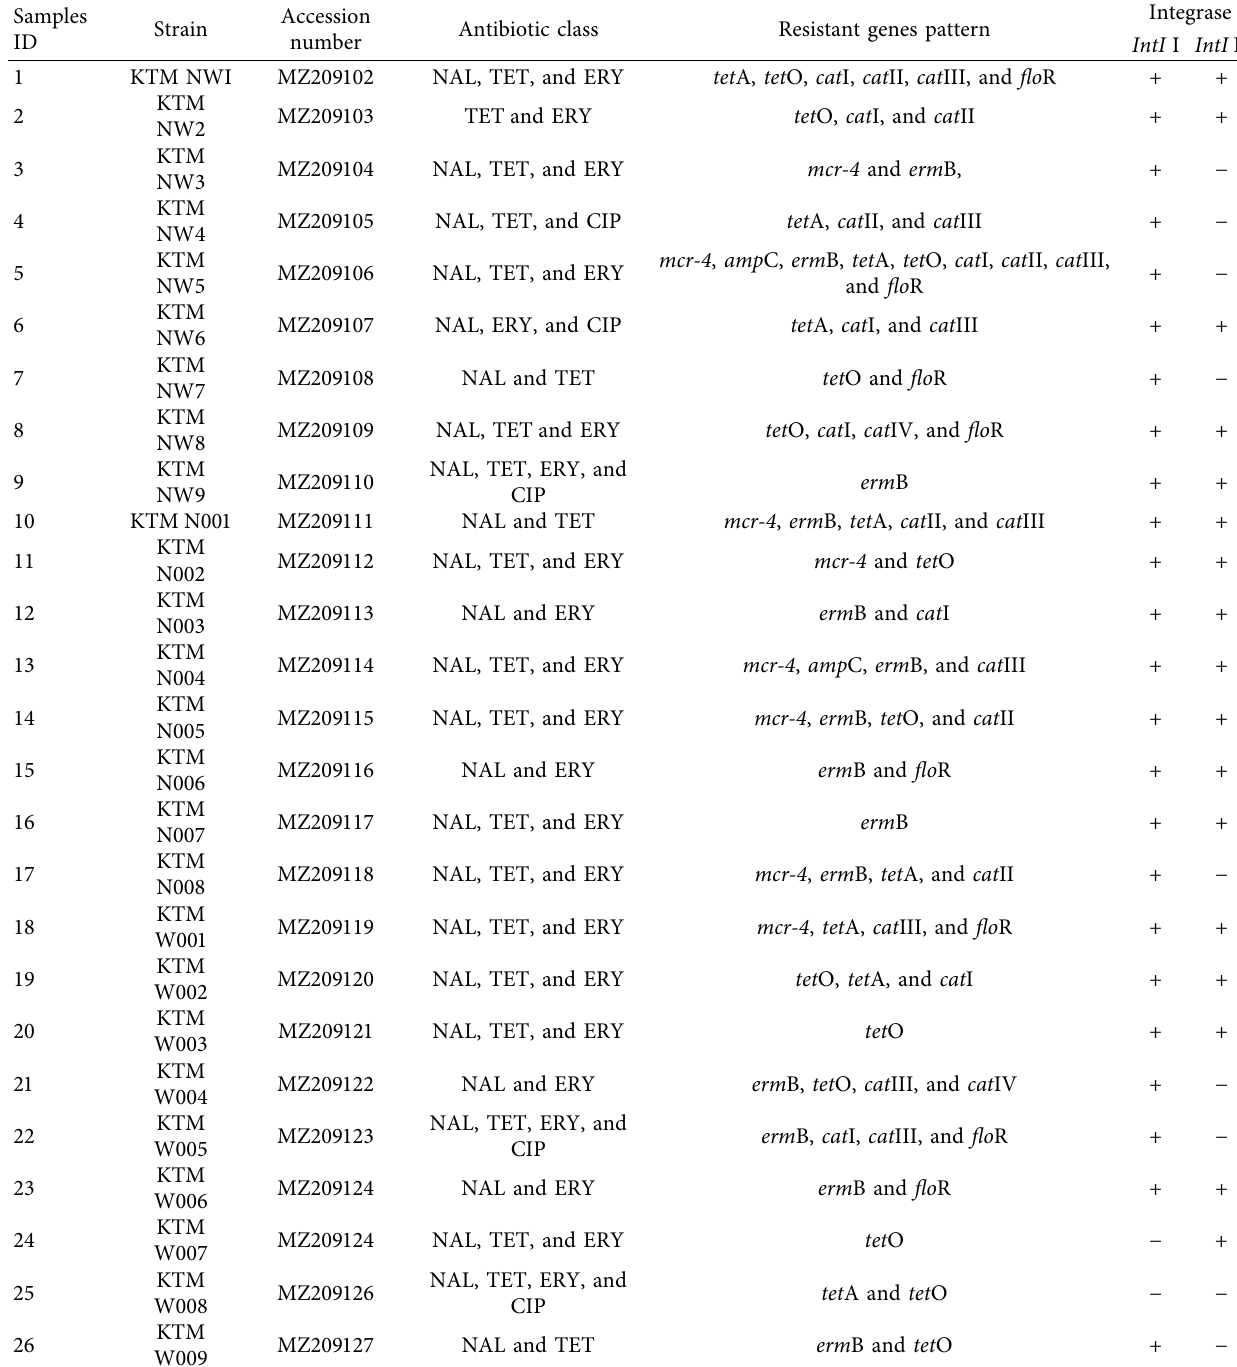
Table 3: Distribution of integrons, phenotypic, and genotypic antibiotic resistance in C. jejuni strains.